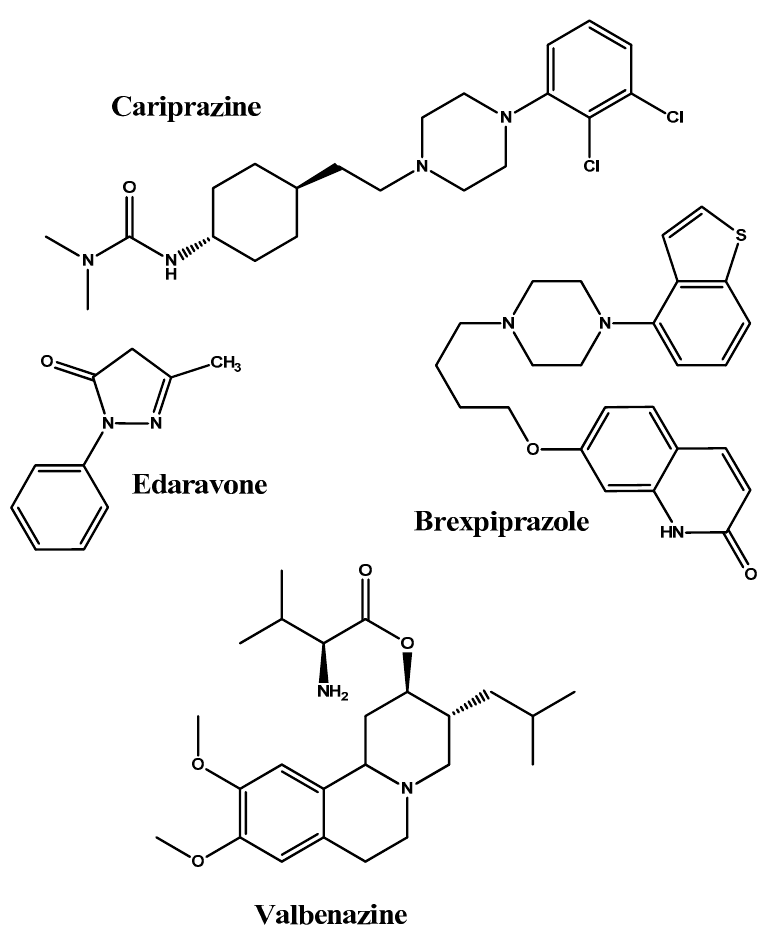
Figure 2. Chemical structures of cariprazine, brexpiprazole, edaravone, and valbenazine.